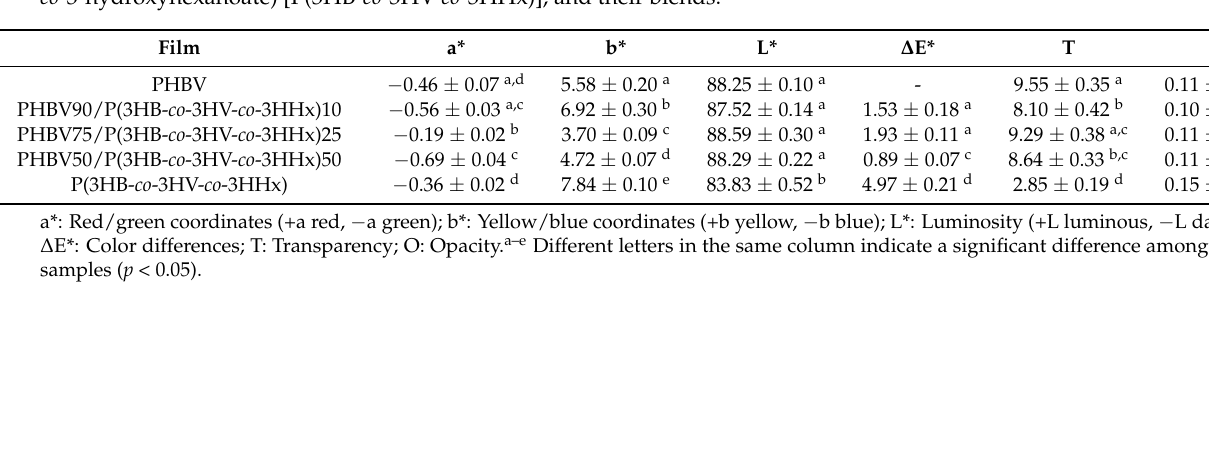
Table 2. Color parameters (a* , b*, L*, and ∆ E*) and transparency (T) and opacity (O) values of the thermo- compressed films of poly(3-hydroxybutyrate- co -3-hydroxyvalerate) (PHBV), poly(3-hydroxybutyrate- co -3-hydroxyvalerate- co -3-hydroxyhexanoate) [P(3HB- co -3HV- co -3HHx)], and their blends.